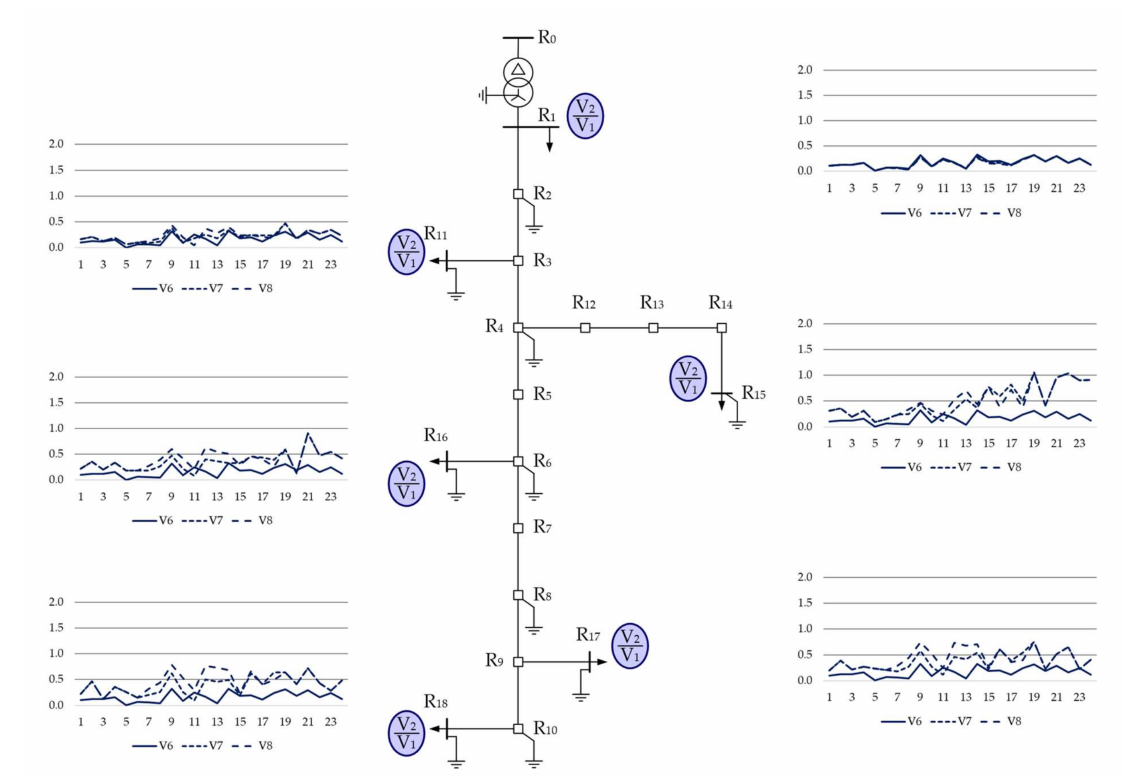
Figure A17. Daily simulation results for variants V6, V7, and V8: negative sequence component of bus voltage (%).